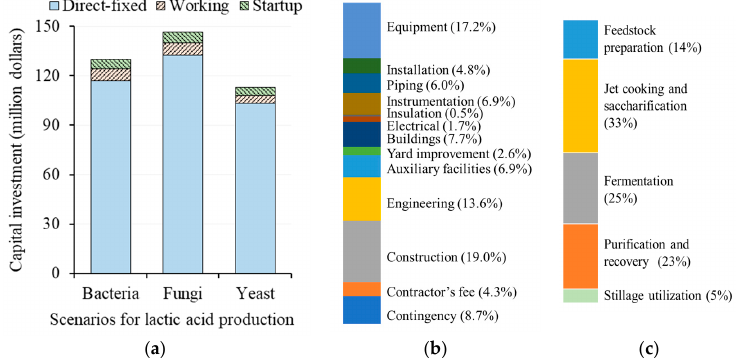
Figure 3. Capital investment for the facility producing 100,000 t/y of lactic acid from corn grain using different fermentation pathways ( a ); share of different components in the direct-fixed capital for the facility using the bacteria-based pathway ( b ); cost share of equipment for different conversion steps for the facility using the bacteria-based pathway ( c ).